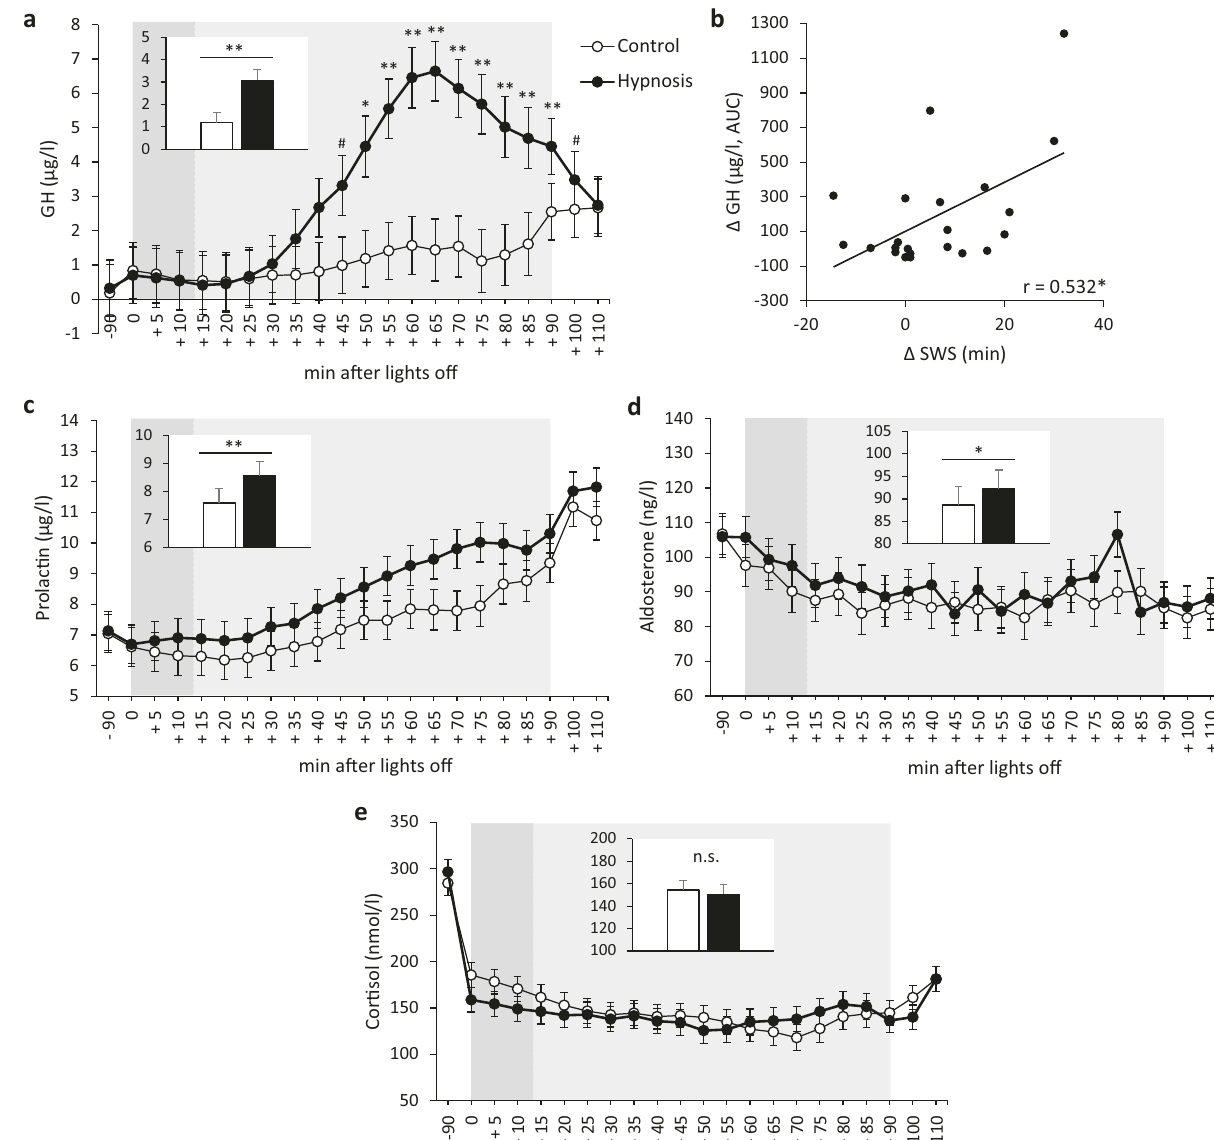
Fig. 2 Effects of hypnotic suggestions on hormone levels. a Estimated marginal means (±SEM) of growth hormone levels in the Hypnosis condition (black circles) vs. the Control condition (white circles). b Correlations of changes in SWS duration in the Hypnosis relative to the Control condition with changes (in the area under the curve, AUC) of GH levels. c – e Estimated marginal means (±SEM) of ( c ) prolactin, ( d ) aldosterone, and ( e ) cortisol levels in the Hypnosis condition vs. the Control condition. Light gray area indicates nap time, darker gray area within nap time indicates duration of the audio tape. ** p < 0.01, * p < 0.05, # p < 0.10 for the Condition main effect of the linear mixed models analyses shown in the insets, for post hoc pairwise comparisons at single time points if the Condition × Time interaction was signi fi cant, and for the correlation coef fi cient; n.s. not signi fi cant; n = 23 for a , c – e ; n = 21 for b (one participant had to be excluded for the correlational analyses due to too many missing values for the calculation of the AUC and one because of missing polysomnography